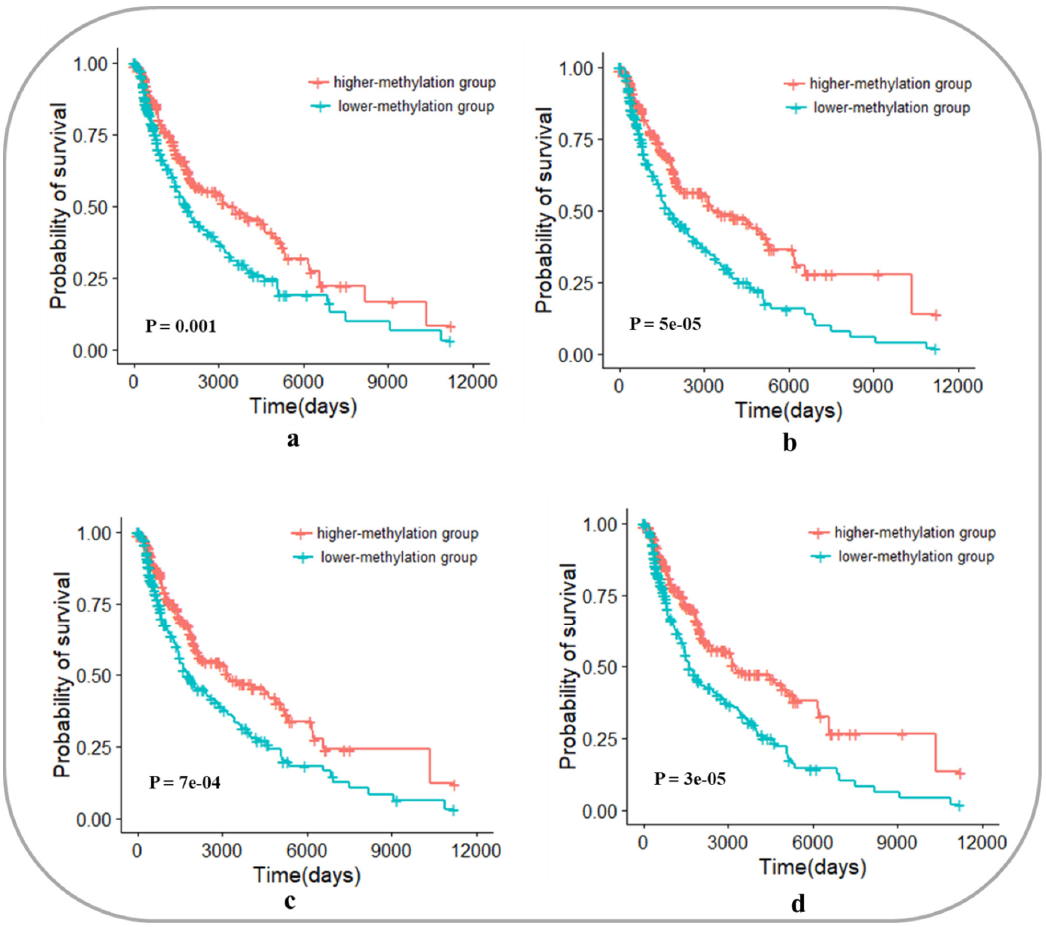
Figure 9. Survival analysis of APPL1 , BCL2L2 , TRIM3 , and UEVLD as biomarkers in skin cutaneous melanoma. ( a ) Survival analysis of APPL1 as a biomarker in skin cutaneous melanoma; ( b ) Survival analysis of BCL2L2 as a biomarker in skin cutaneous melanoma; ( c ) Survival analysis of TRIM3 as a biomarker in skin cutaneous melanoma; ( d ) Survival analysis of UEVLD as a biomarker in skin cutaneous